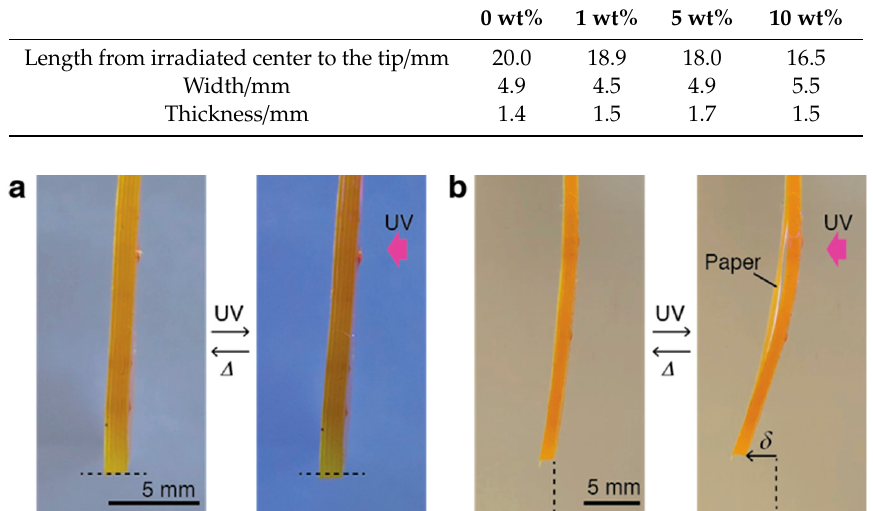
Figure 2. Shape change of a hybrid silicone with azobenzene powder (10 wt%) before and after ultraviolet (UV) light irradiation. ( a ) Elongation of the hybrid silicone when free to expand. ( b ) Bending of the hybrid silicone when constrained by a paper. Dotted lines in panels show the initial position before UV irradiation. In both cases, UV light (365 nm) was irradiated 3 min at 600 mW/cm 2 .